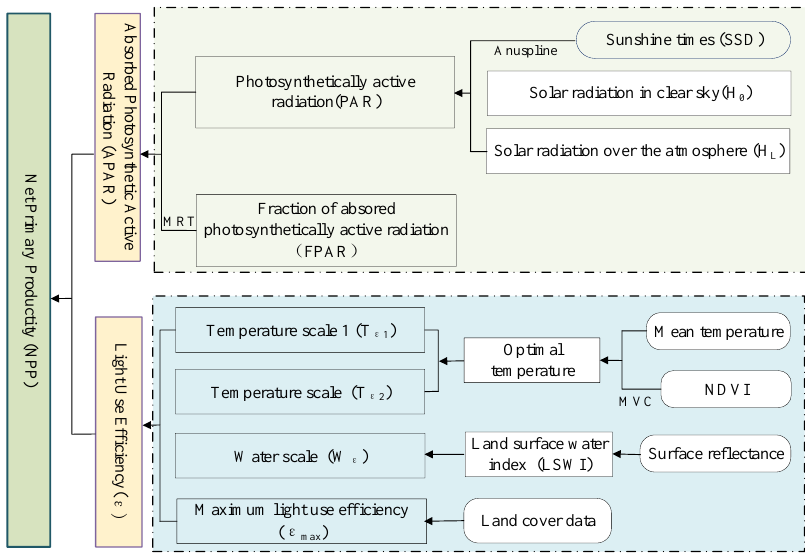
Figure 2. Flowchart of the Global Production Efficiency Model (GLO-PEM) to estimate the Net Primary Productivity (NPP) in Northeast China.